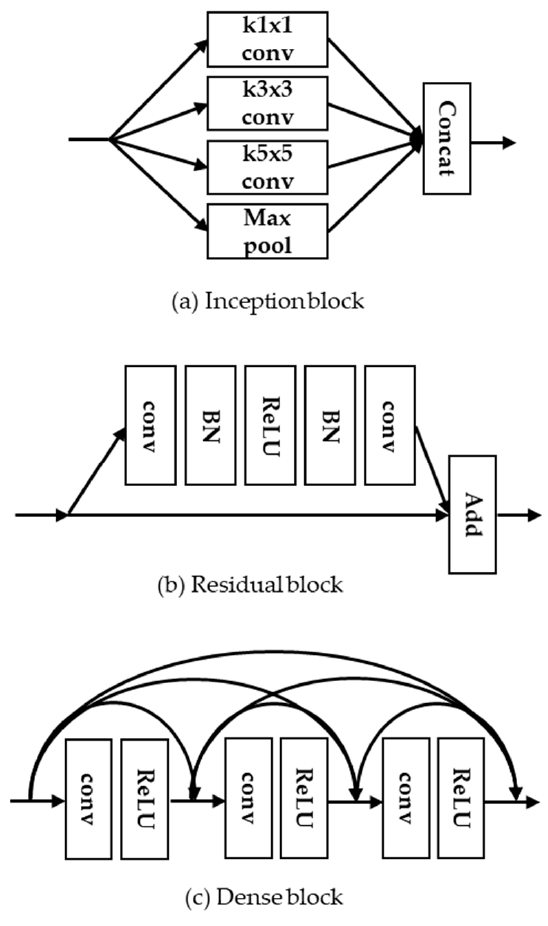
Figure 2. Examples of CNN-based network blocks. ( a ) Inception block; ( b ) residual block; and ( c ) dense block.